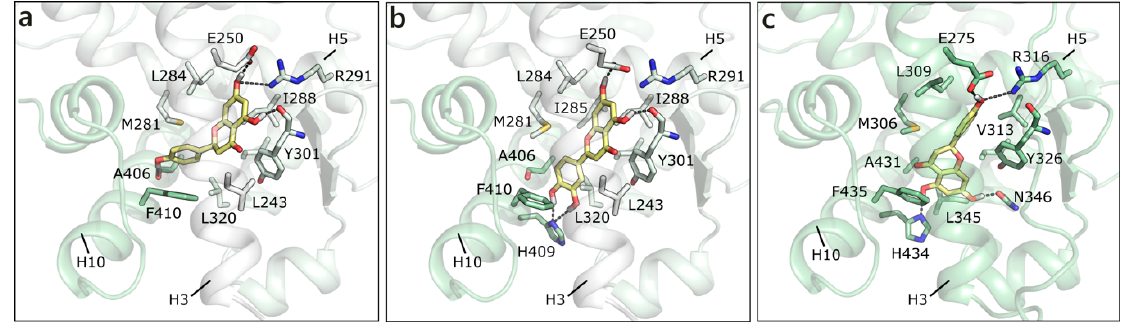
Figure 7. Docking poses of NRG ( a ) and of LUT ( b ) in ERR β ( PDB ID 6lit [84]) and of NRG ( c ) in ERR γ. The protein is shown in transparent light green cartoon, the residues lining the binding site and the ligands are shown in capped sticks and colored light green and yellow, respectively. Helices and residues lining the pocket are labelled, hydrogen bonds are displayed as black dashed lines.